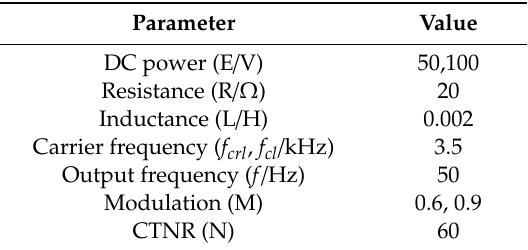
Figure 12. Experiment platform of hybrid cascaded 7-level inverter.